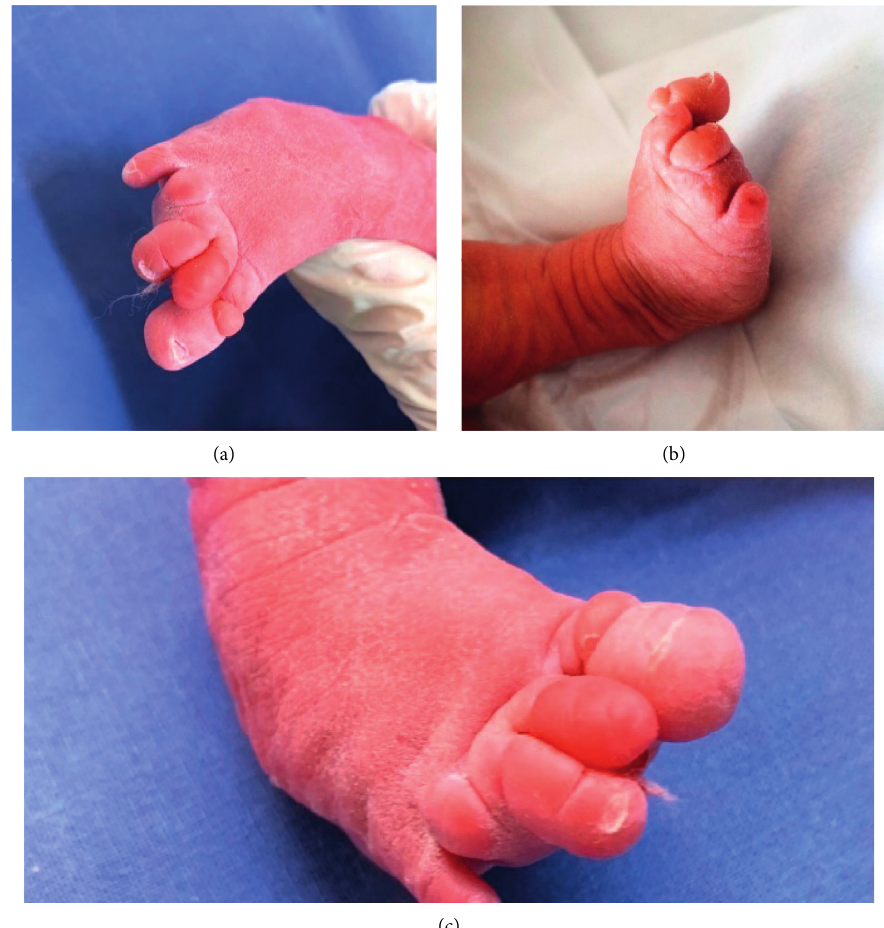
Figure 3: Right foot. Clubfoot on the right (a); syndactyly between 2 and 3 rd toe (b); macrodactyly of the big toe and partial amputation of the fourth toe